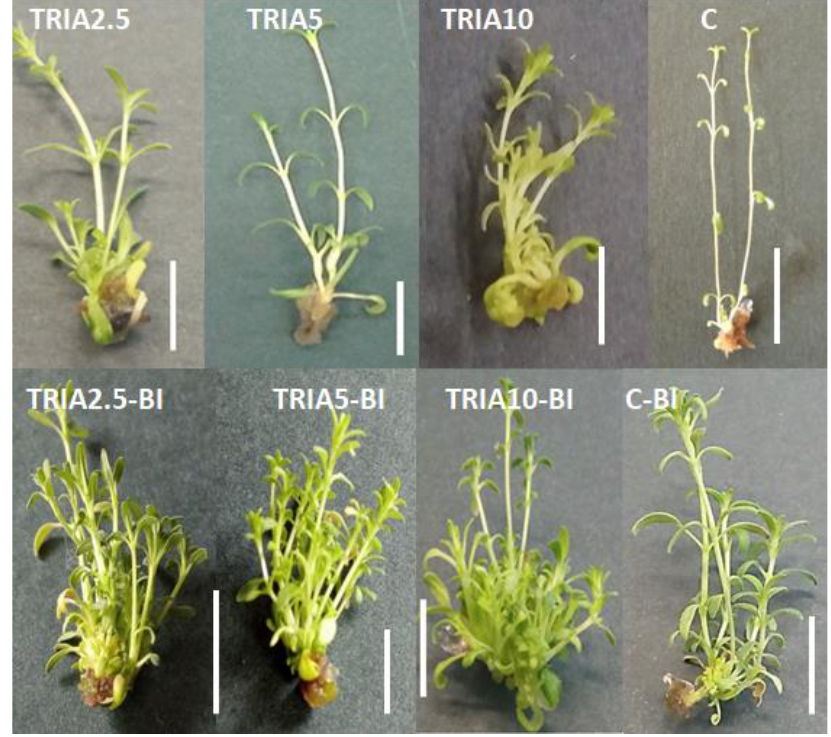
Figure 1. D. forrestii shoots growing five weeks on MS medium containing: TRIA (µg/L) or TRIA (µg/L) and 0.5 mg/L BAP and 0.2 mg/L IAA (TRIA-BI), C-medium without growth regulators, C-BI- medium with 0.5 mg/L BAP and 0.2 mg/L IAA. Bar 1 cm.